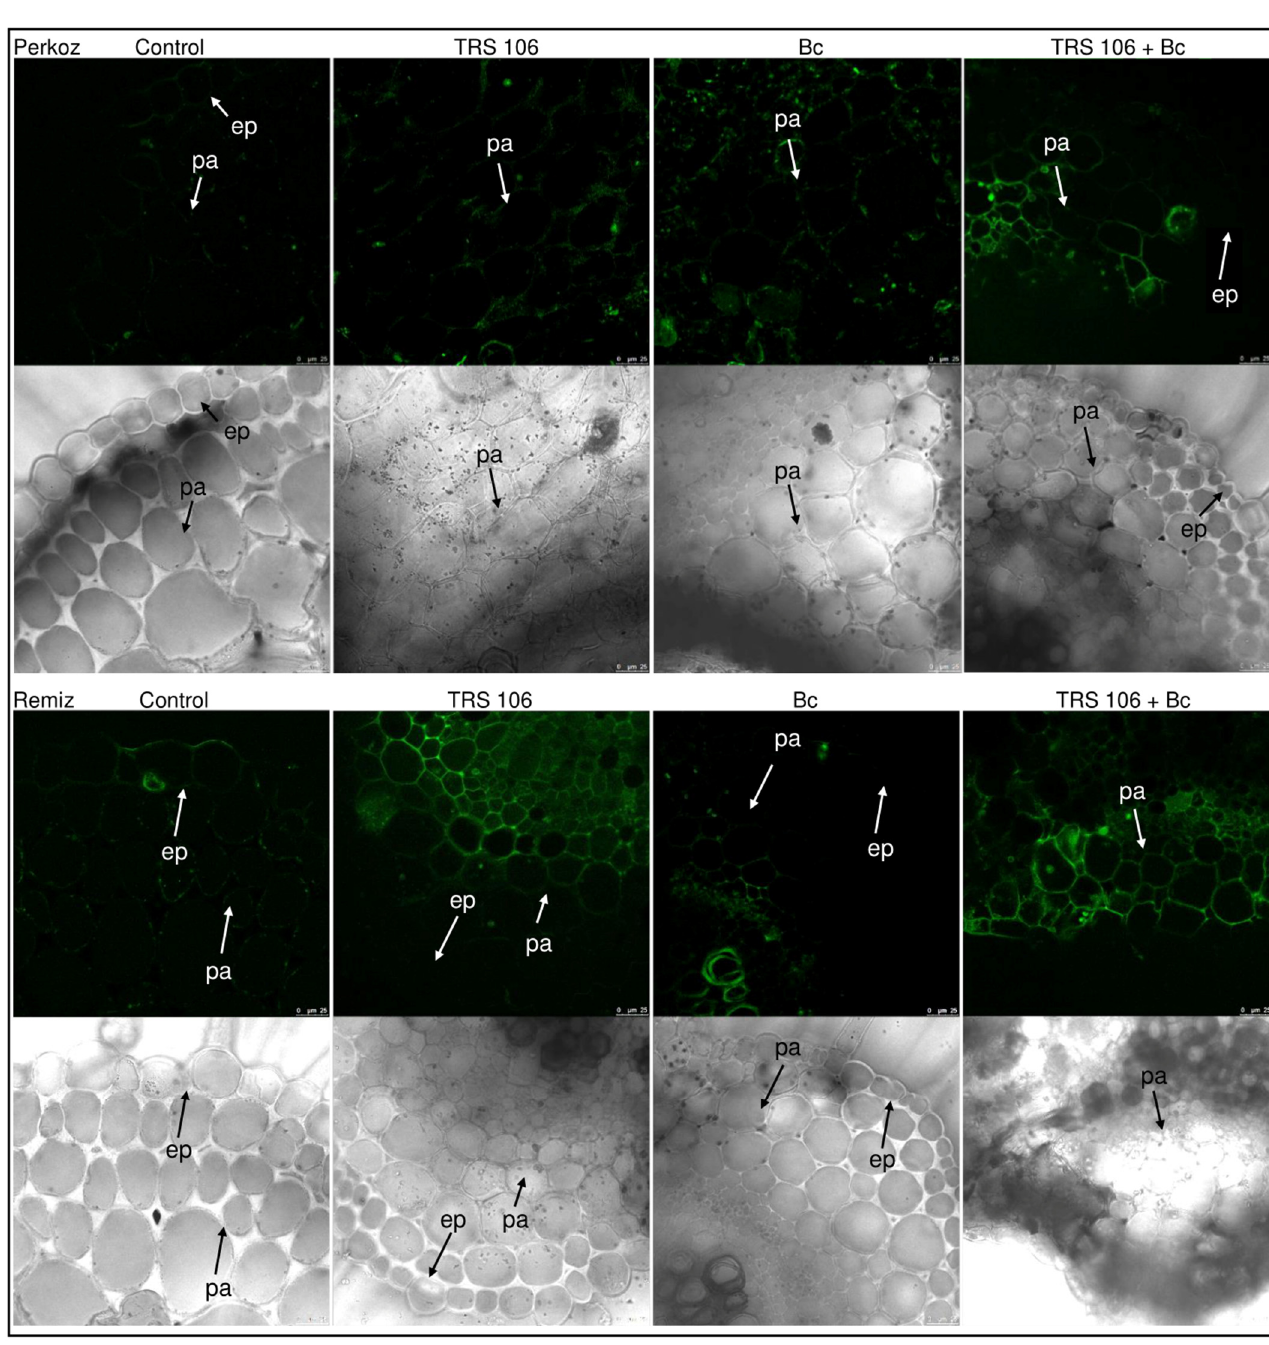
Figure 5. Histochemical visualizations of nitric oxide (NO) in cross sections of tomato leaves. Fluorescent confocal microscopy was used to detect NO localization. Light green fluorescence of NO was observed mainly in the cells localized in the parenchyma and epidermal tissue, and in the area of vascular bundles. DAF-2DA was used for histochemical visualization of NO. As a negative control, leaf pieces were immersed in a buffer containing cPTIO which eliminates NO (Figure S1). The monochrome images are added to confirm and facilitate the localization of the organelle. Abbreviations for variants are as in Figure 1; pa, parenchyma; ep, epidermis.